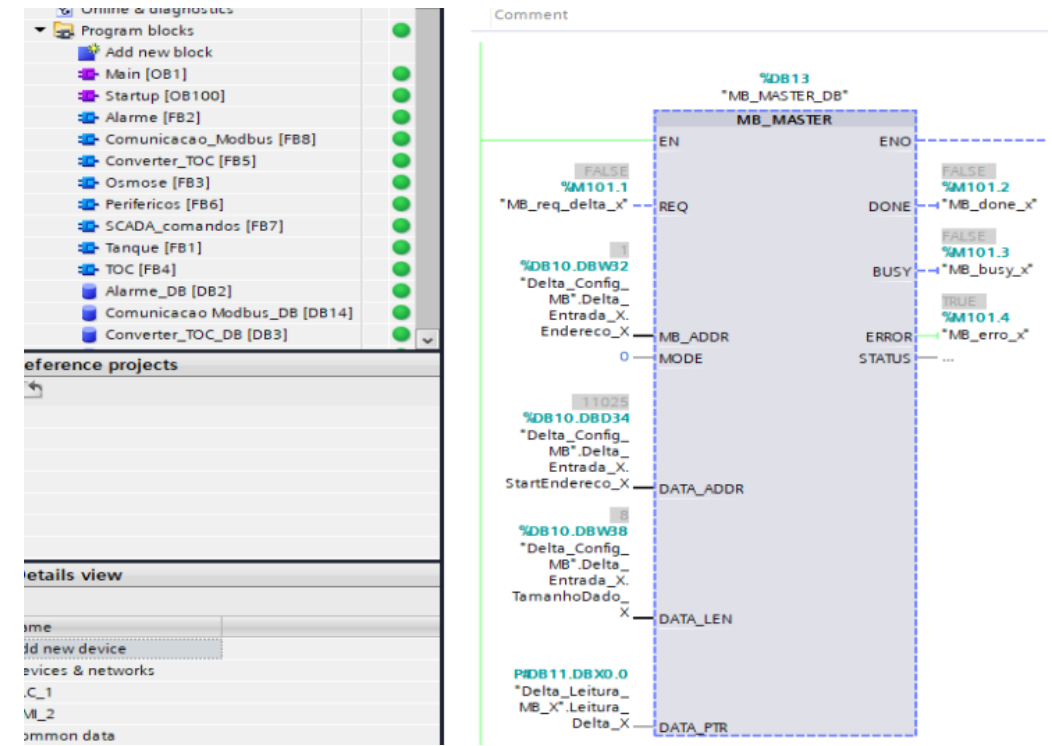
Figure 9. TIA Portal software configuration to add the block diagram of the slave equipment configuration in the new automation